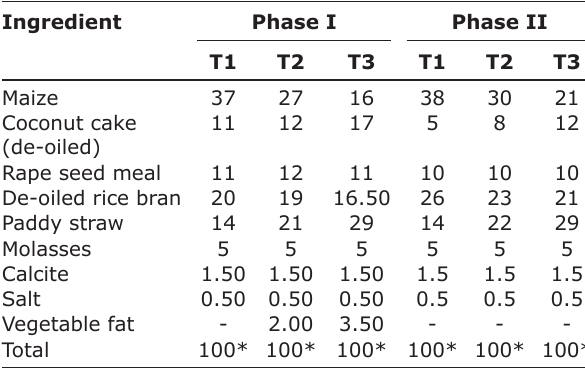
Table-1: Ingredient composition of experimental complete feeds offered to cows in Phases I and II, kg. Ingredient Phase